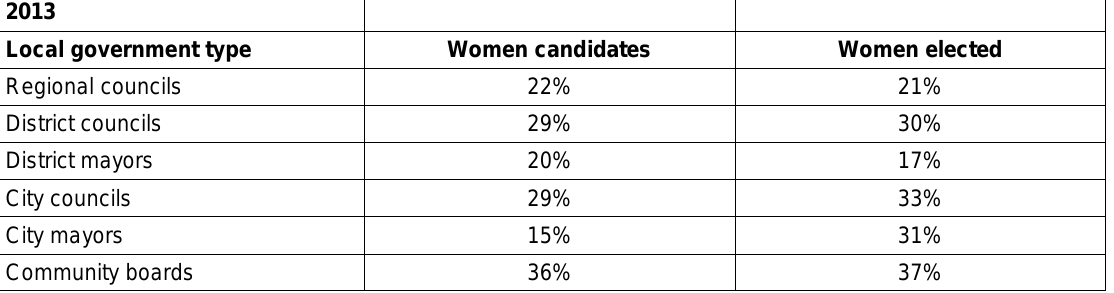
Table 1: The proportion of women elected to New Zealand local government at the 2013 local elections